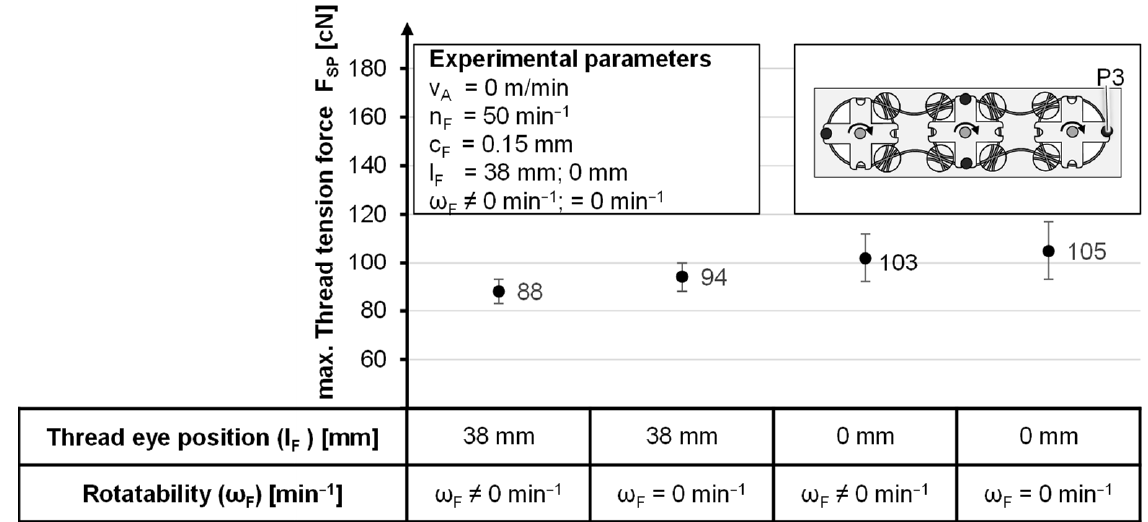
Figure 11. Maximum yarn tension force as a function of the yarn eye position and the rotatability of the dished foot.